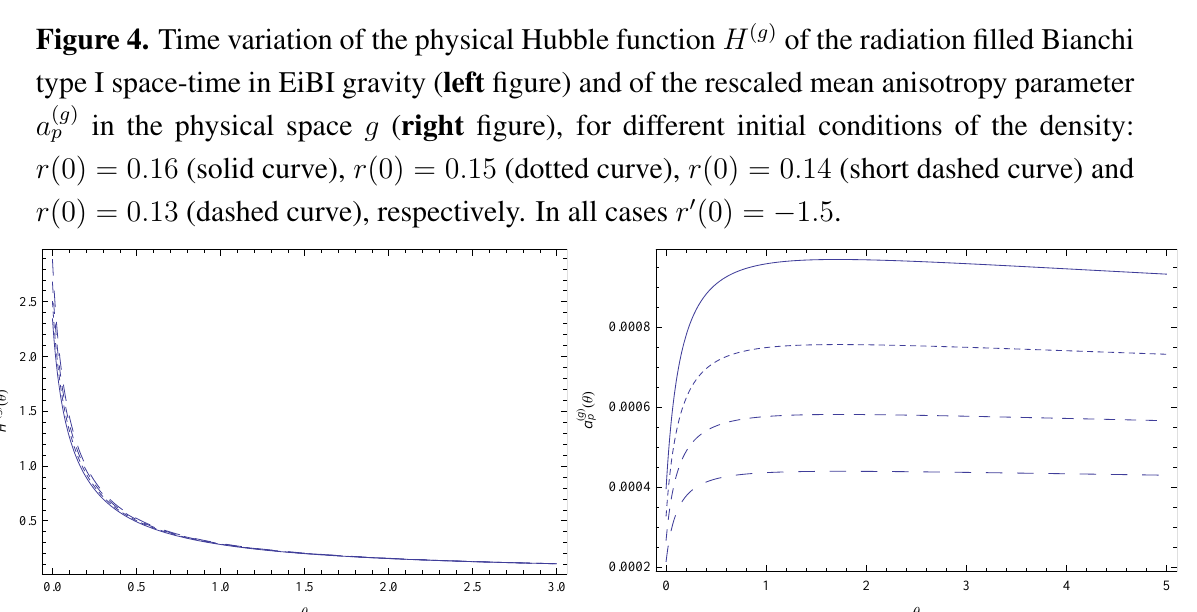
Figure 4. Time variation of the physical Hubble function H ( g ) of the radiation filled Bianchi type I space-time in EiBI gravity ( left figure) and of the rescaled mean anisotropy parameter a ( g )